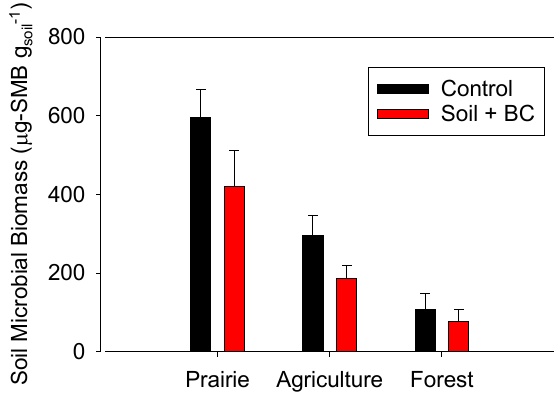
Figure 2. Observed impacts on soil microbial biomass (SMB) as a function of biochar addition across the three soils. The error bars represent one standard deviation of the triplicate assessments. The asterisk indicates a statistically significant difference between the control and biochar addition with a t -test at the 95% confidence level ( p < 0.05) grouped by soil